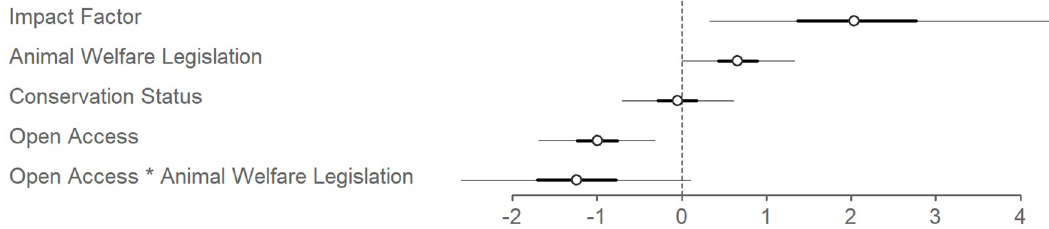
Fig 2. Association between journal characteristics and presence of animal care policies across 206 journals that commonly publish wildlife research. Coefficients shown are odds ratios from a logistic model, with thick and thin bars representing 50 and 95% confidence intervals, respectively. X scale unit is per 2 SDs of